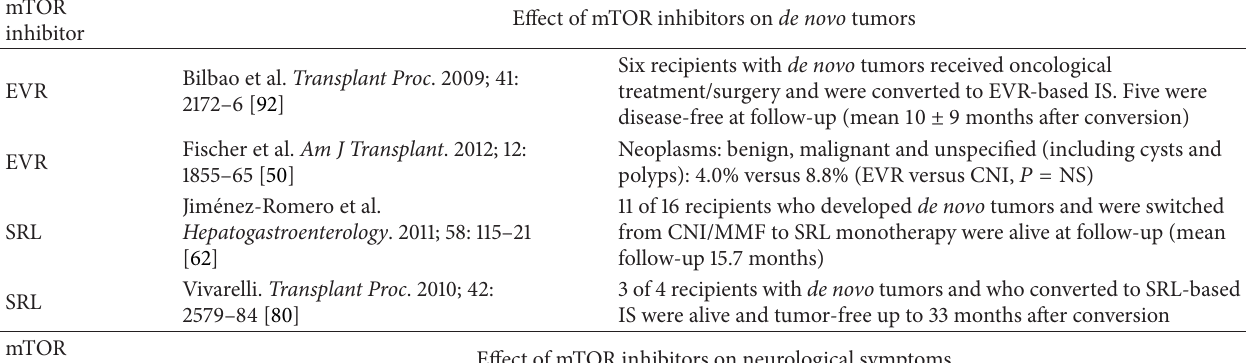
Table 8: Other properties of mTOR